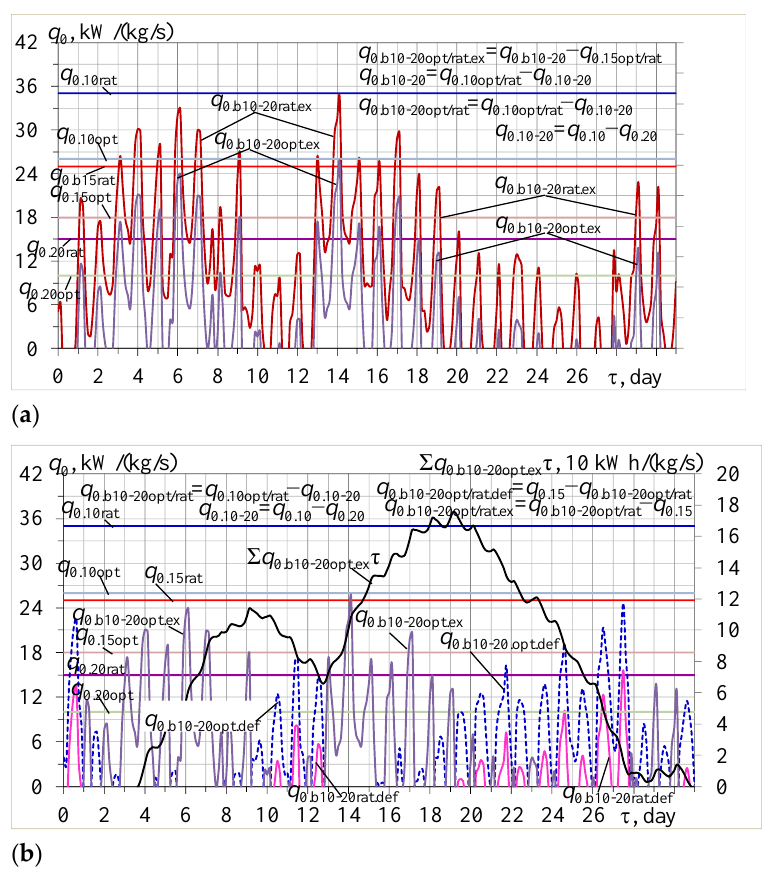
Figure 7. Actual values of booster refrigeration capacity exceedance q 0.b10-20opt.ex and q 0.b10-20rat.ex over q 0.15 ( a ) and its deficit q 0.b10-20opt.def and q 0.b10-20rat.def based on the optimal and rational design values q 0.10opt and q 0.10rat for conditioning outdoor air to 10 °C; summarized monthly refrigeration energy exceedance ∑ q 0.b10-20opt.ex over q 0.15 ; ( b ): q 0.b10-20rat = q 0.10rat − q 0.10-20 , q 0.b10-20rat.ex = q 0.b10-20rat − q 0.15 , q 0.b10-20opt.def = q 0.15 − q 0.b10-20opt , q 0.b10-20rat.def = q 0.15 − q 0.b10-20rat , ∑ q 0.b10-20rat.ex = ∑ ( q 0.b10-20rat − q 0.15 ) τ , ∑ q 0.b10-20opt.ex = ∑ ( q 0.b10- 20opt − q 0.15 ) τ .